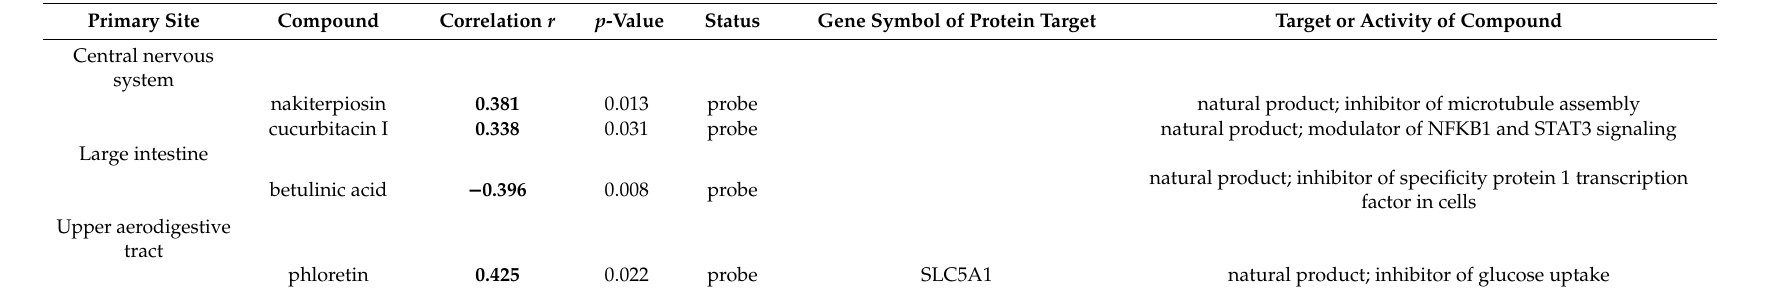
Table 2. The correlation between STAT3 expression and sensitivity to natural